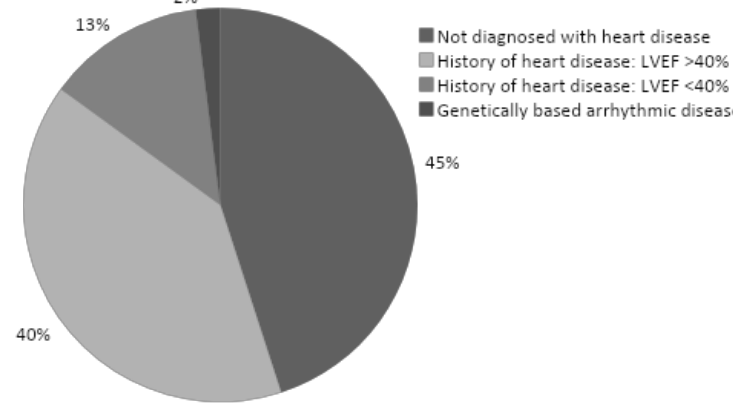
Fig. 3. The different groups that contribute to the total number of SCDs (adapted from Wellens 2014 (ref. 47